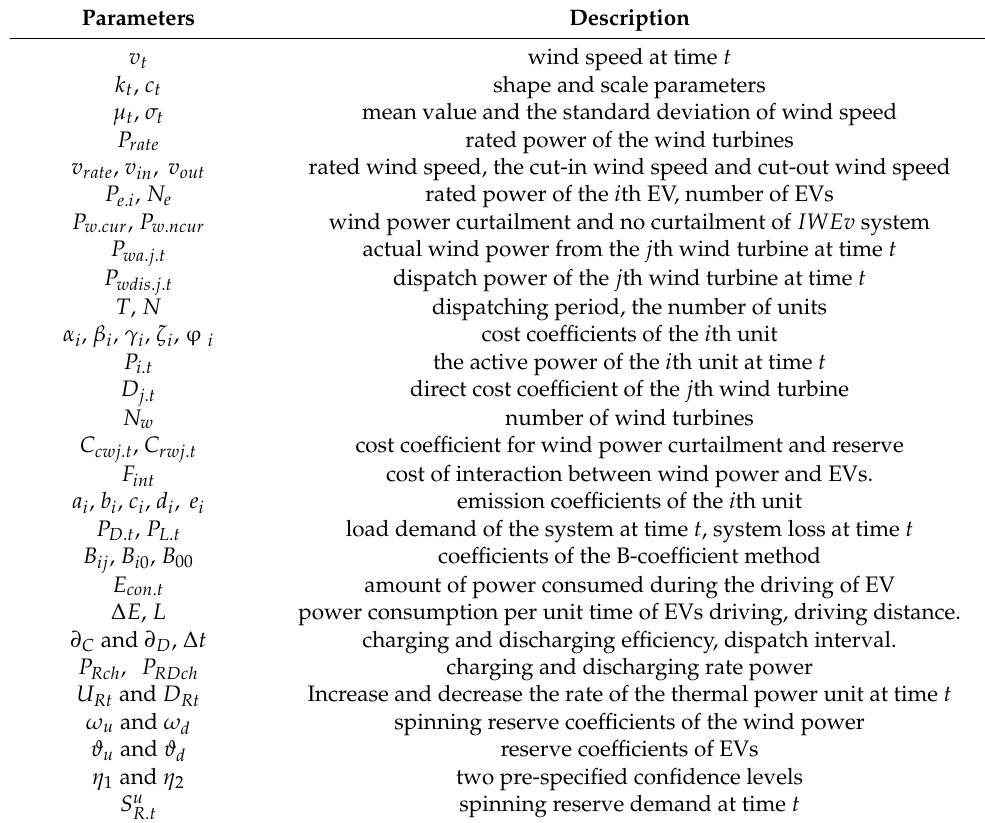
Table 1. System parameters and their